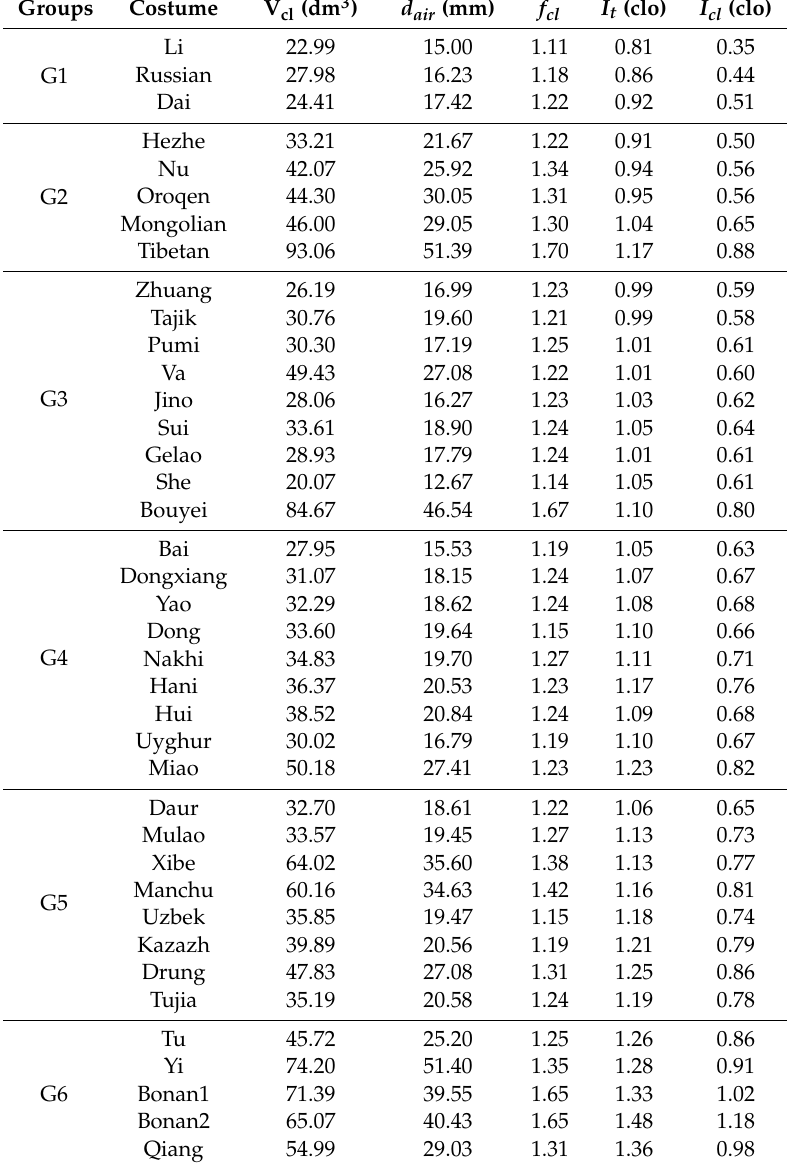
Table 2. Air volume, air gap size, clothing area factor, total thermal insulation, and intrinsic thermal insulation of the selected ethnical